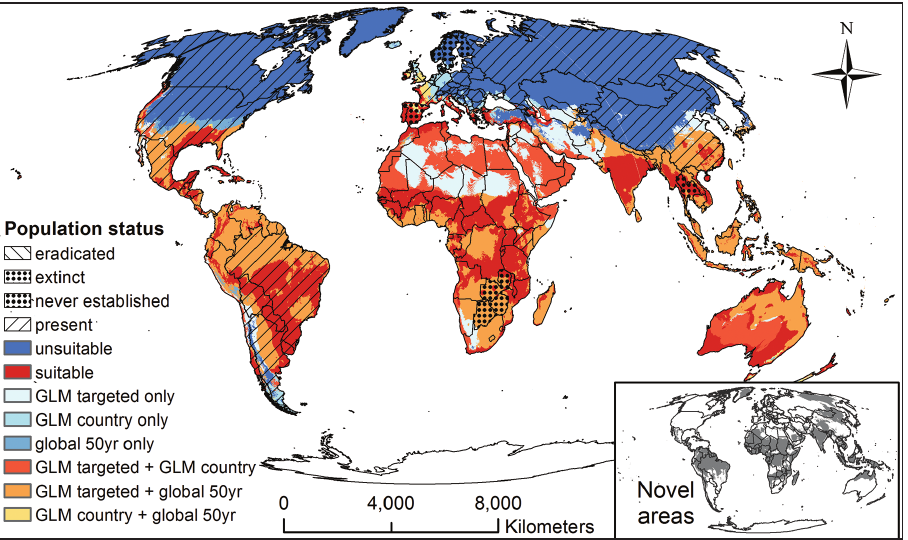
Figure 3. Global predictions of habitat suitability for coypu ( Myocastor coypus [Molina, 1782]). Ensem- ble predictions using three models at the global scale including an ecophysiological based model based on average monthly climate data from WorldClim, a correlative model using country background and a cor- relative model using a taxonomically targeted background approach. Maps are in Mollweide